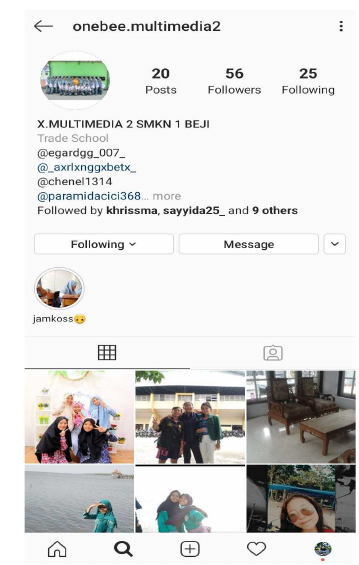
Figure 3. Instagram class account of Multimedia 2